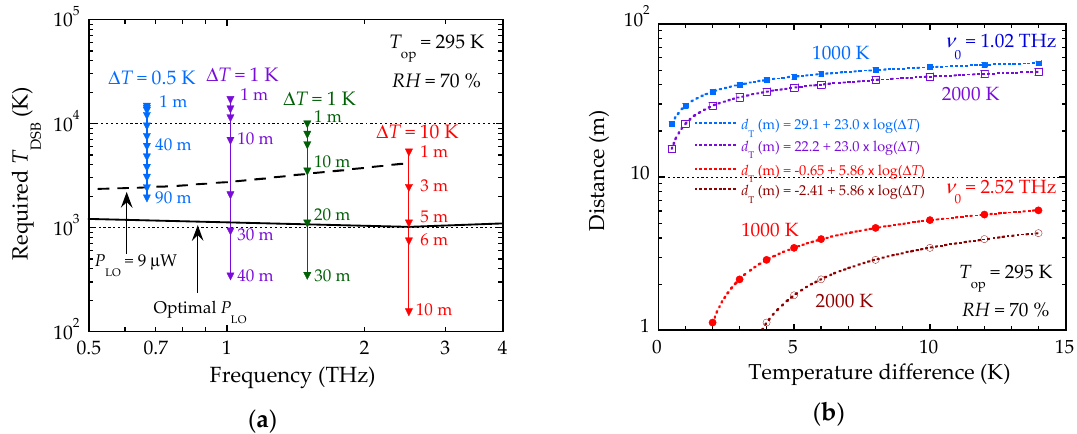
Figure 17. Standoff detection DSB requirements: ( a ) Required noise temperature as a function of ν 0 for various distances at specified Δ T and fixed humidity; simulated T DSB values for device B are also shown at both optimal P LO conditions - solid curve (Table 2) and at fixed P LO = 9 μ W - dashed curve [27]; ( b ) Required distance vs. temperature difference relationship to achieve T DSB = 1000 K or 2000 K, at fixed RH . Symbols: Computed values, dotted curves: Best fits (according to functions indicated).